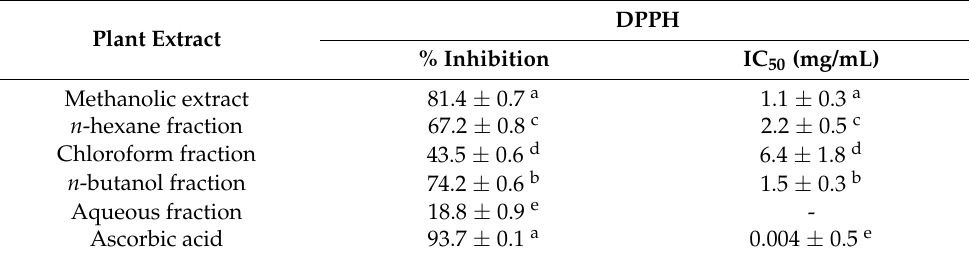
Table 4. Antioxidant activity (DPPH) of Neurada procumbens .